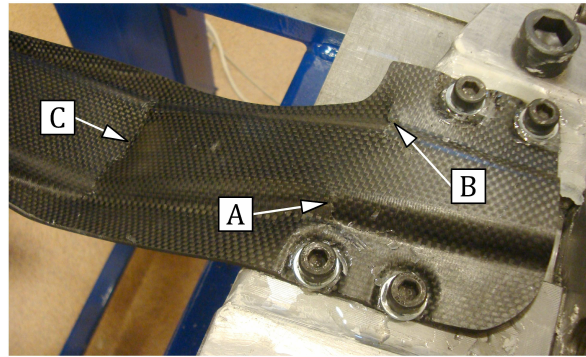
Figure 9: A fragment of the beam destroyed during the test with marked crack